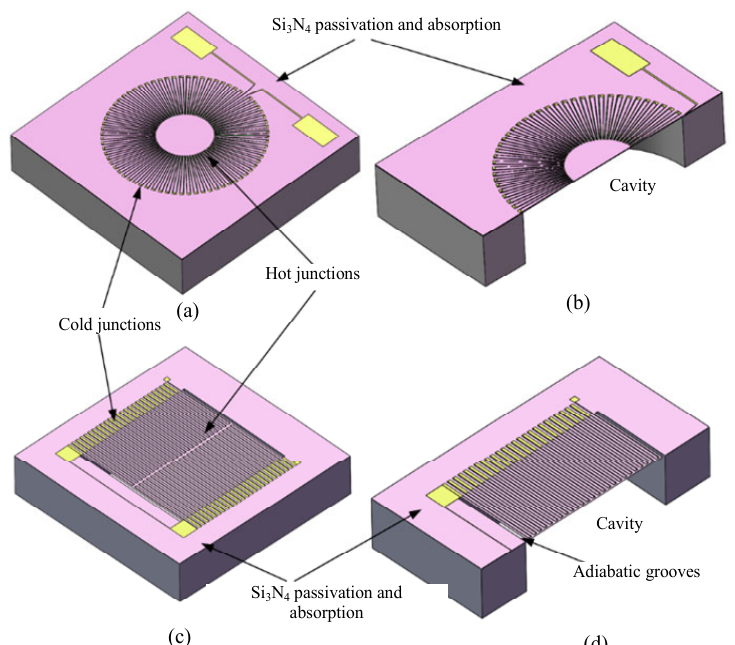
Fig. 1 Schematic diagram of the thermopile structure designed in this paper: (a) circular thermopile, (b) section of the circular thermopile, (c) rectangular double-ended thermopile, and (d) section of the rectangular double-ended thermopile.